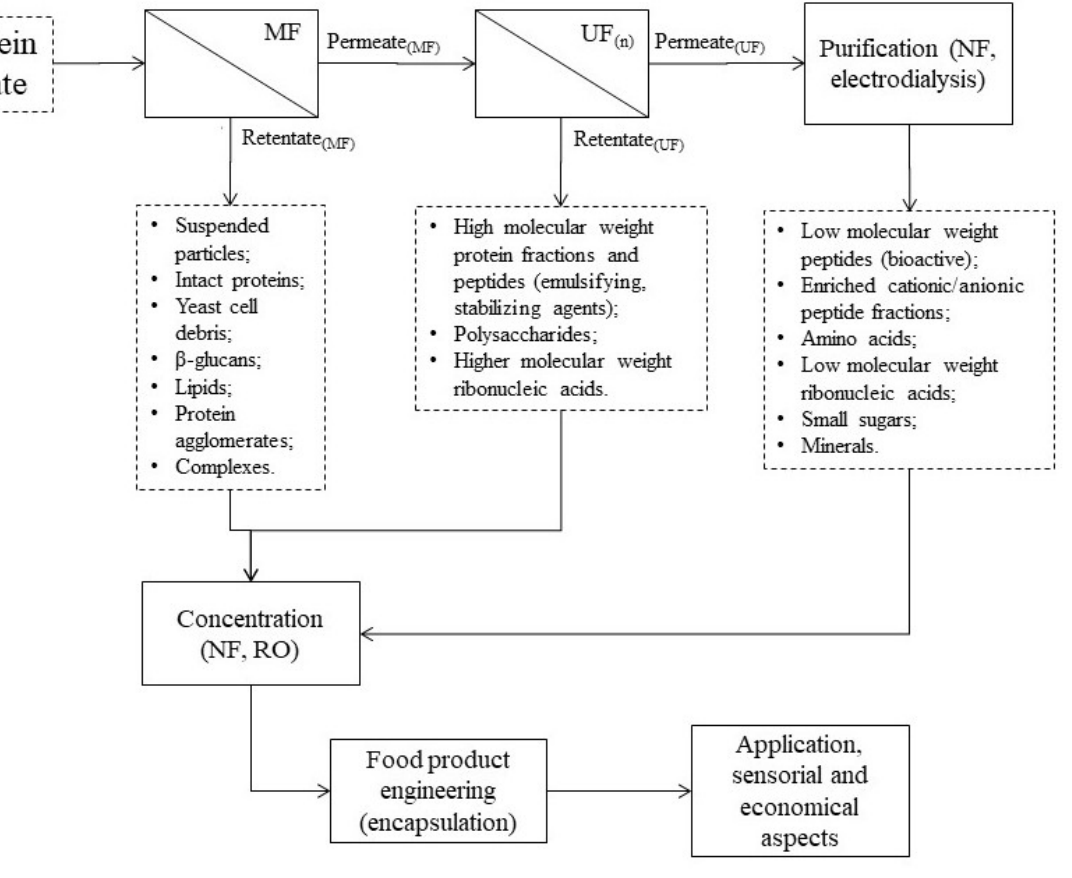
Figure 3. Use of membrane separation technology in the recovery of protein-rich ingredients and bioactive peptides from yeast protein hydrolysates and the main compounds recovered in